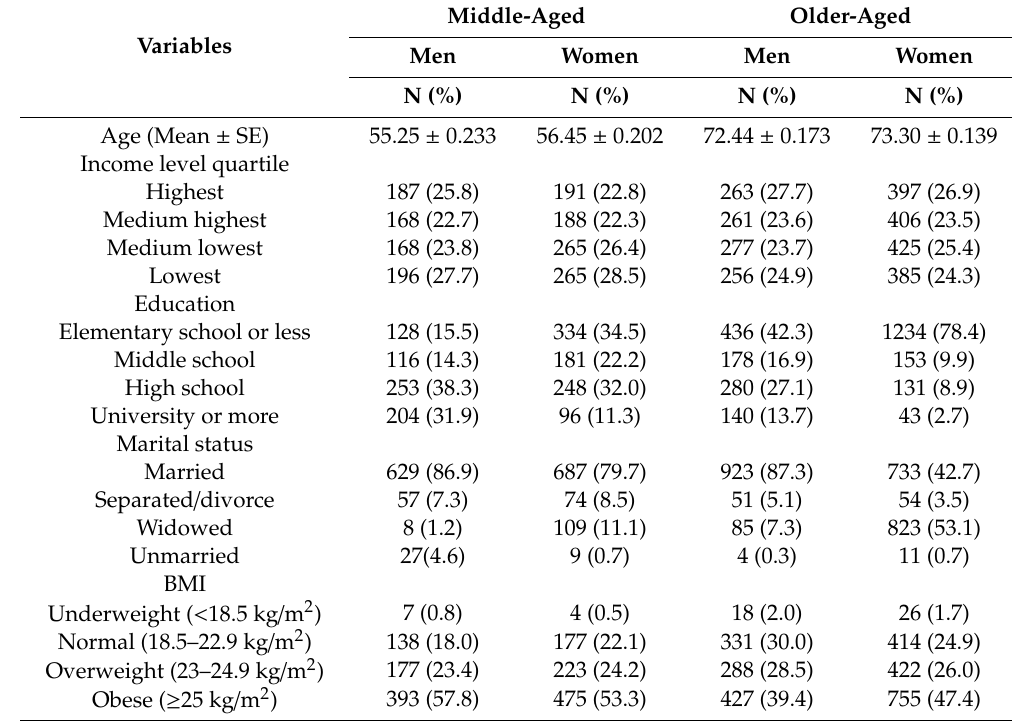
Table 1. General characteristics of the participants (N = 4287).